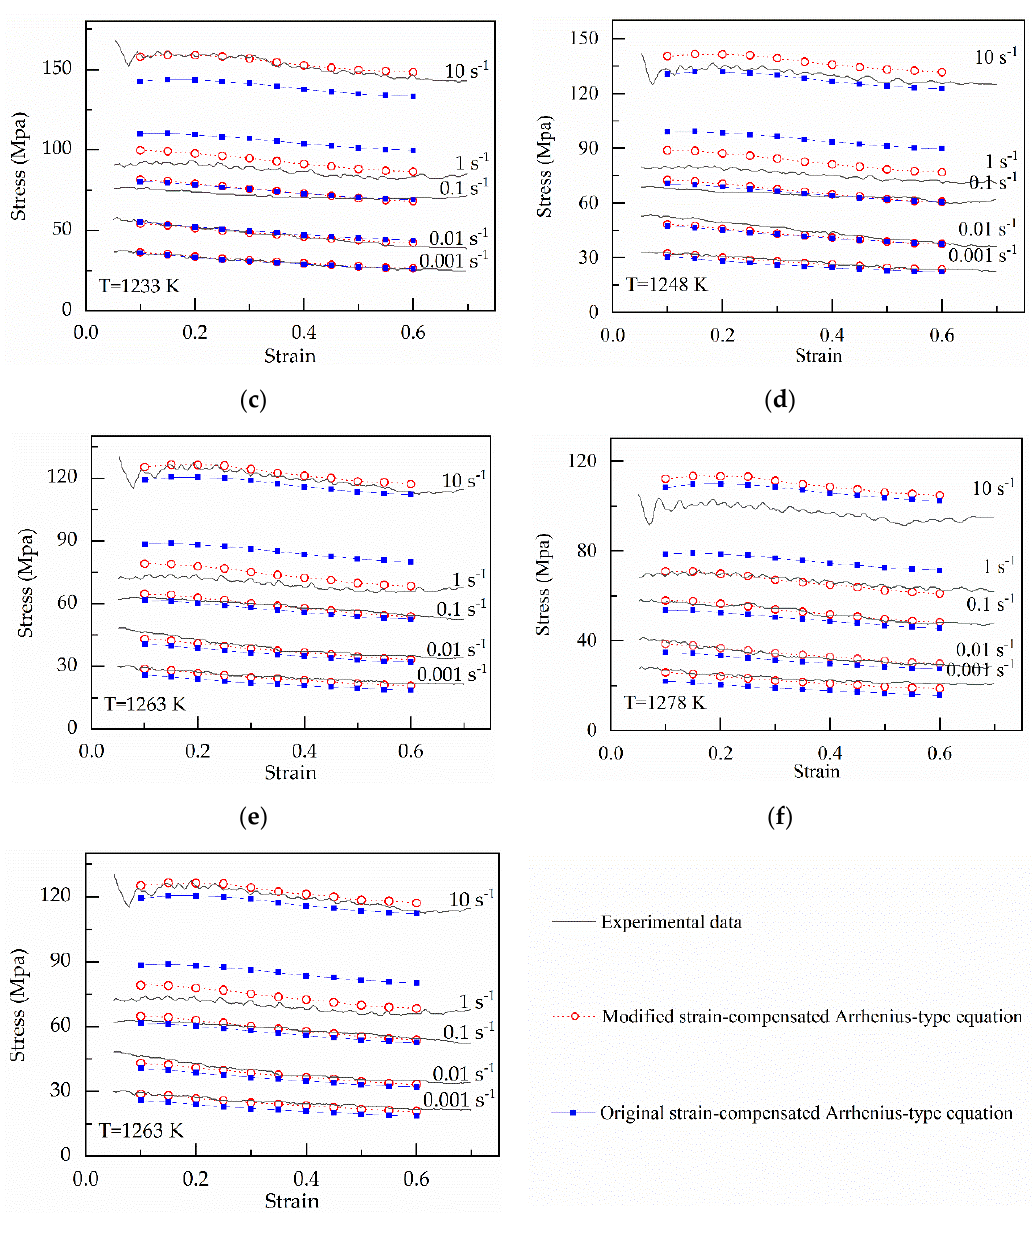
Figure 11. Comparison between the experimental and predicted stress by the original and modified strain-compensated Arrhenius-type equations at ( a ) 1203 K; ( b ) 1218 K; ( c ) 1233 K; ( d ) 1248 K; ( e ) 1263 K; ( f ) 1278 K; ( g ) 1293 K.